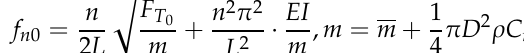
Table 2. Parameters of the flexible pipe model.